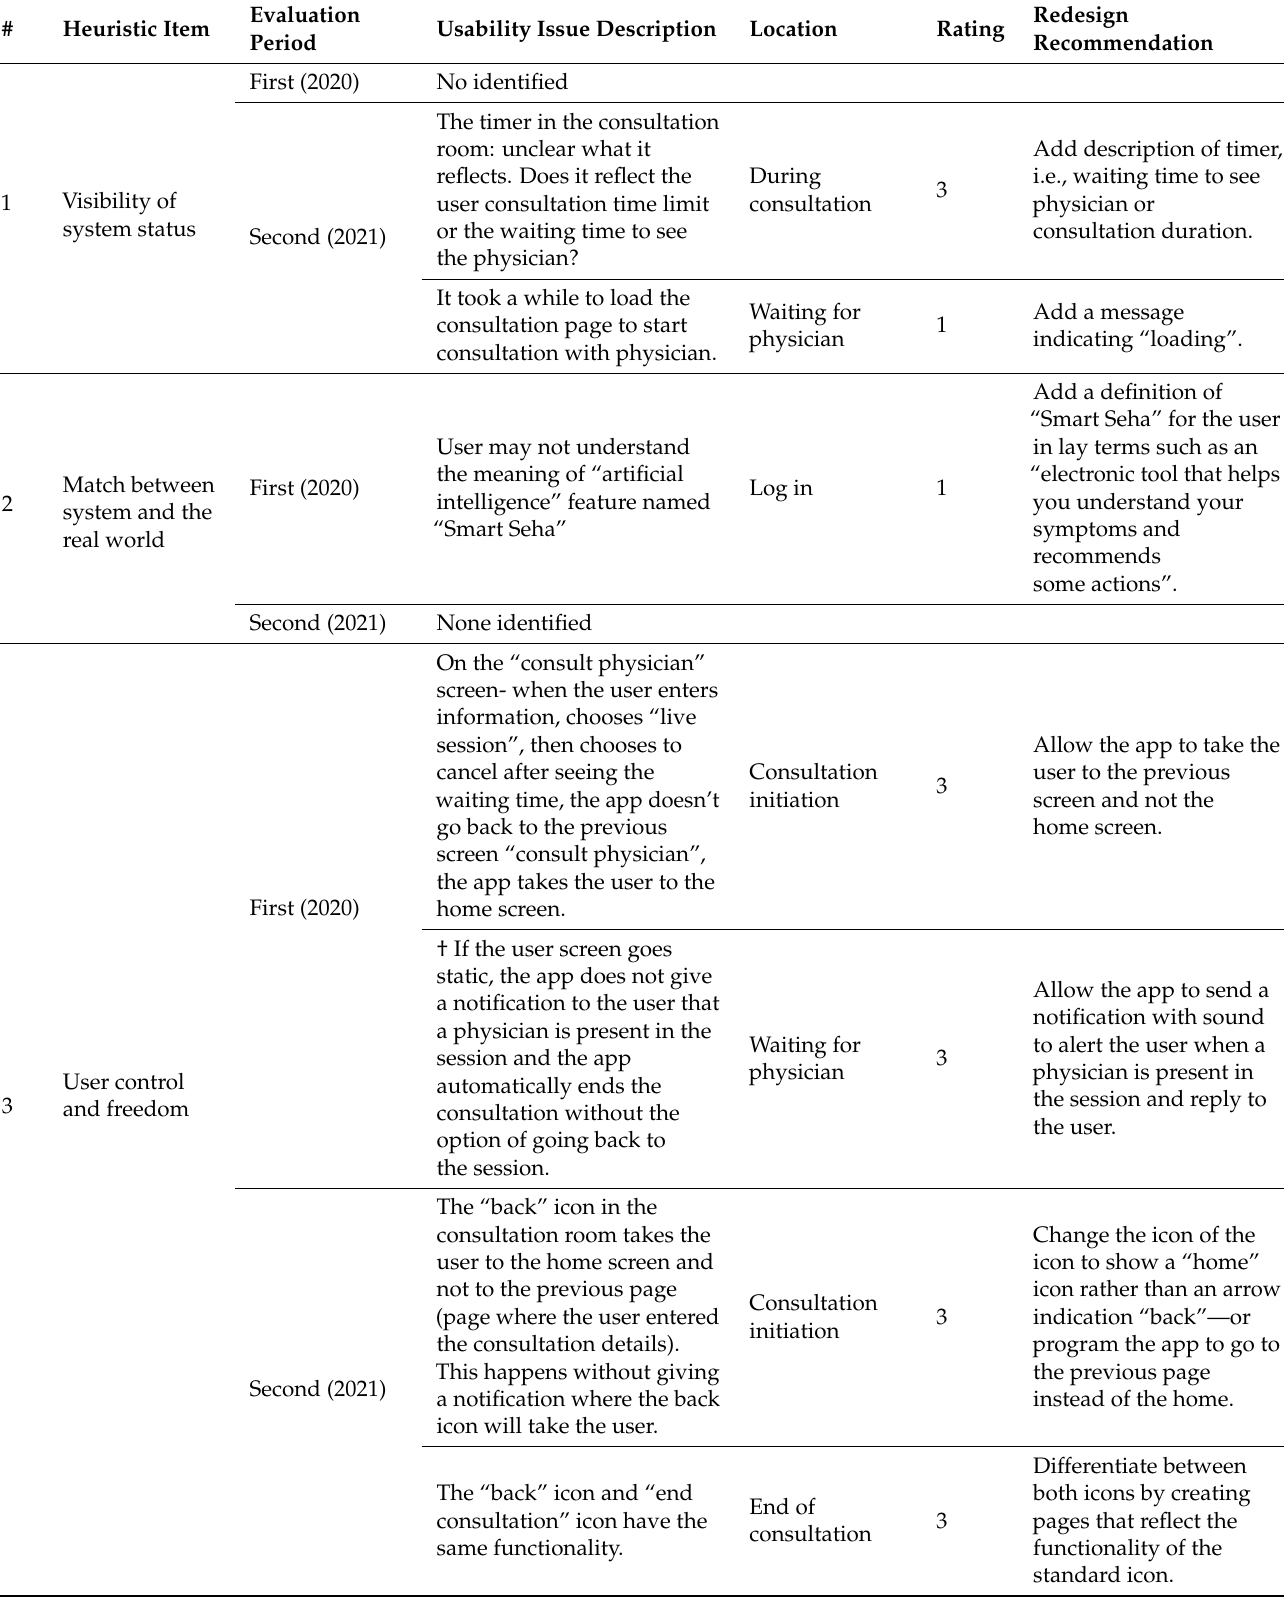
Table A2. “Seha” app (versions 1.0.35 and 1.0.36): usability issues identified based on Nielsen’s